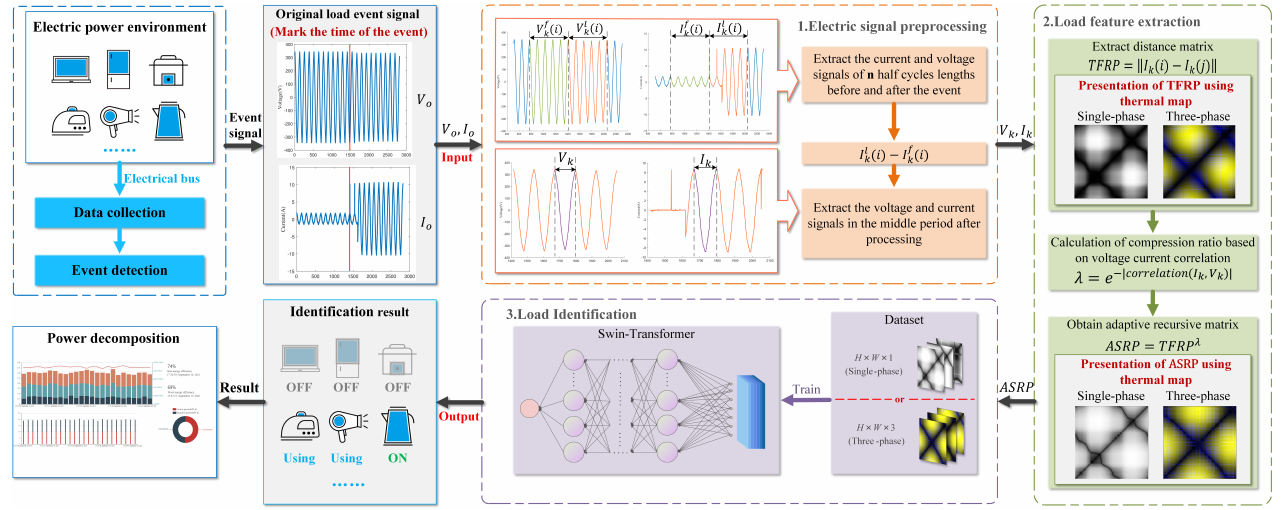
Figure 2. Technology roadmap for non-intrusive load monitoring based on adaptive scaling recur- rence